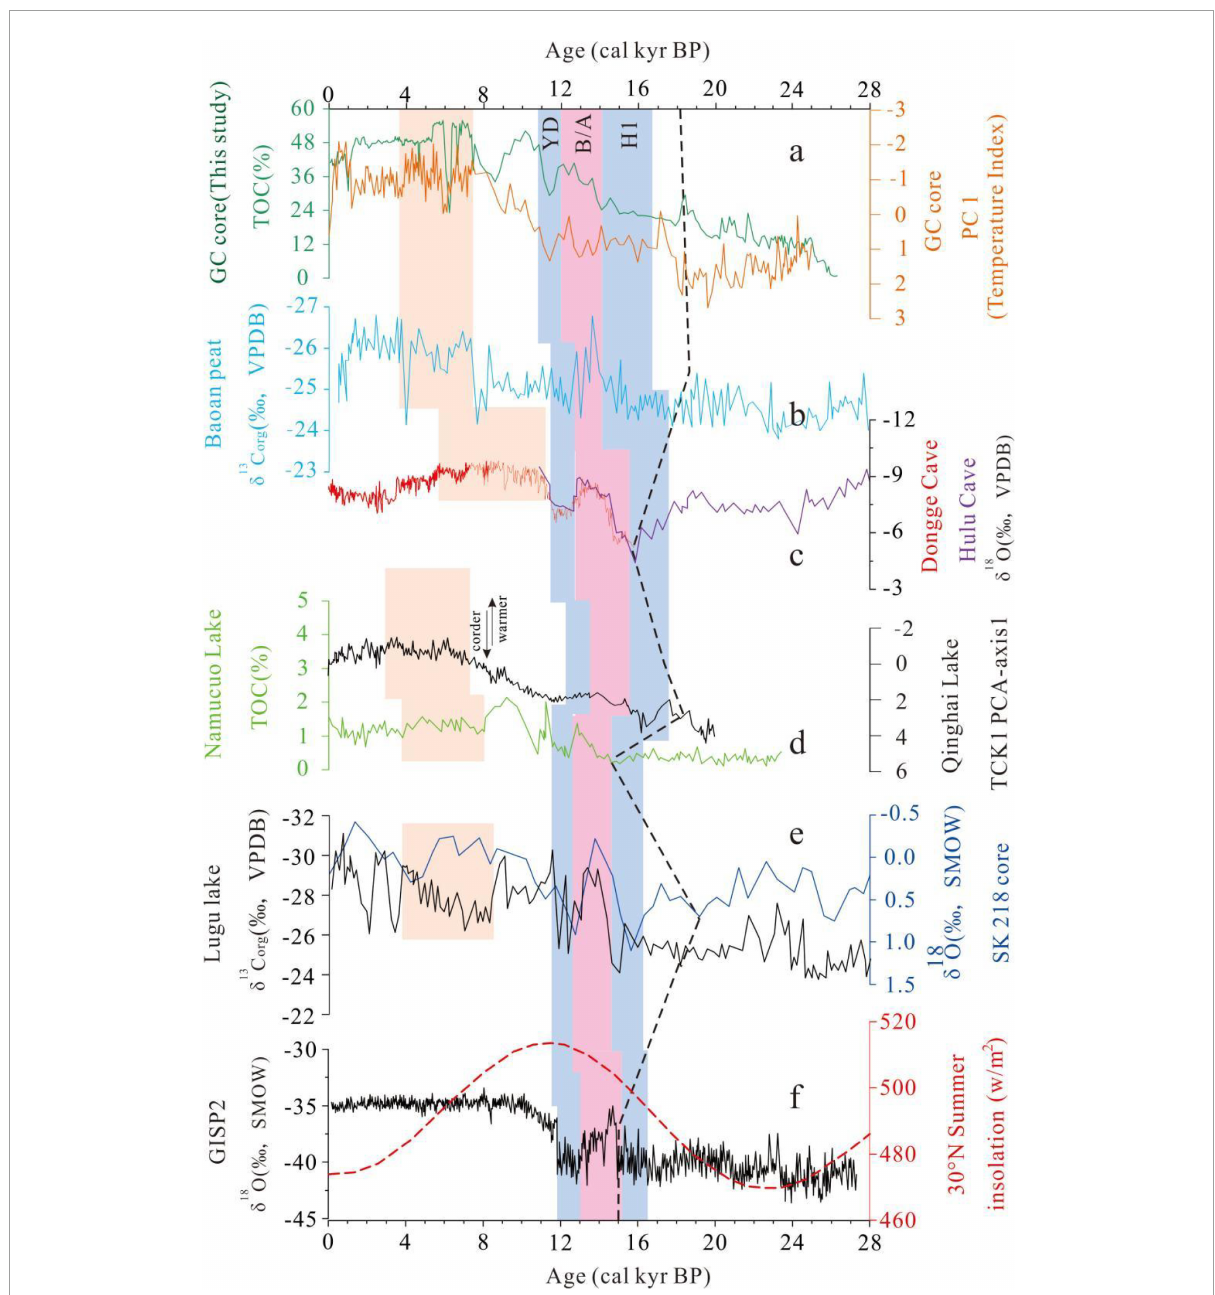
FIGURE7 Comparison of the paleoenvironmental records in the GC core with that of other areas since the LGM. (a) Principal component1 (PC1) scores of the pollen in the GC core (orange curve, Deng et al., 2022), this curve can be used as temperature index, the higher the temperature, the smaller the value. TOC percentage content (green curve) of the GC core (this study); (b) δ 13 Corg records of the Baoan peat (Blue curve, Hong et al., 2018), (c) δ 18 O stalagmite record from Dongge Cave (red curve, Dykoski et al., 2005) and Hulu Cave (purple curve, Wang et al., 2001); (d) TOC percentage in sediment core NC08/01 from NamCo Lake, QTP (black curve, Zhu et al., 2015) and the PC1 scores of pollen in core TCK1 from Qinghai Lake, Tengchong (green curve, Xiao et al., 2015); (e) sea surface δ 18 O record from core SK218 in the Indian Ocean (blue curve, Govil and Divakar Naidu, 2011) and δ 13 Corg record in sediment core LG08 from Lugu Lake, Yunnan Province (black curve, Zhang et al., 2018); (f) 30 ◦ N summer insolation curve (red dotted line, Berger and Loutr, 1991) and δ 18 O record from the GISP2 ice core in Greenland (black curve, Stuiver and Grootes, 2000). The black dotted line indicates the first warming period after the LGM at different locations; the blue band indicates the H1 and YD cold events; and the pink band indicates the B/A warm period. The orange band indicates the Holocene